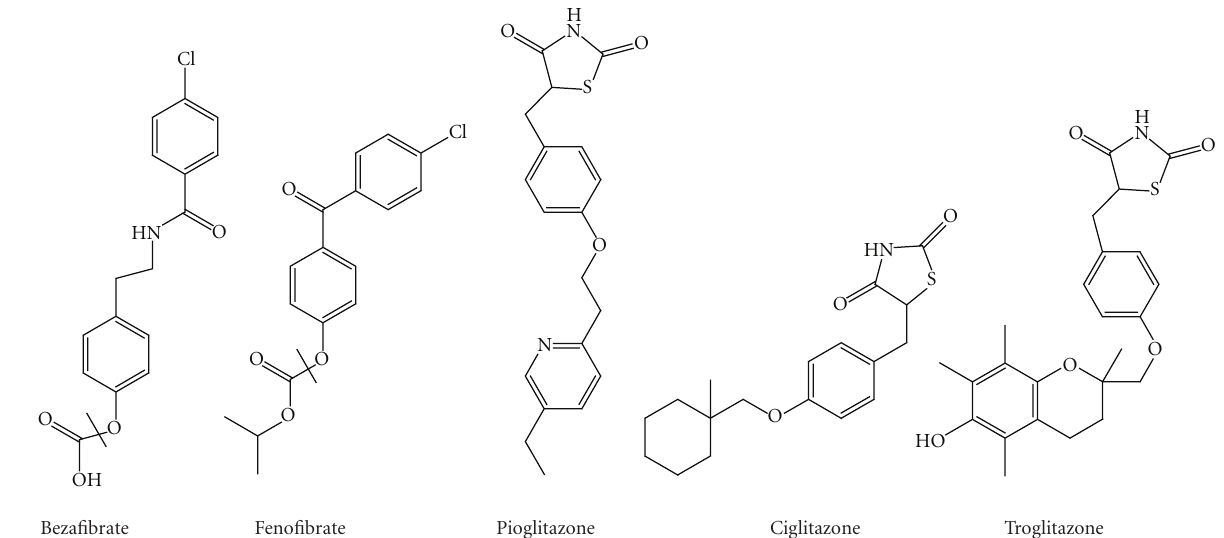
Figure 1: Structure of some drugs acting as PPAR ligands.